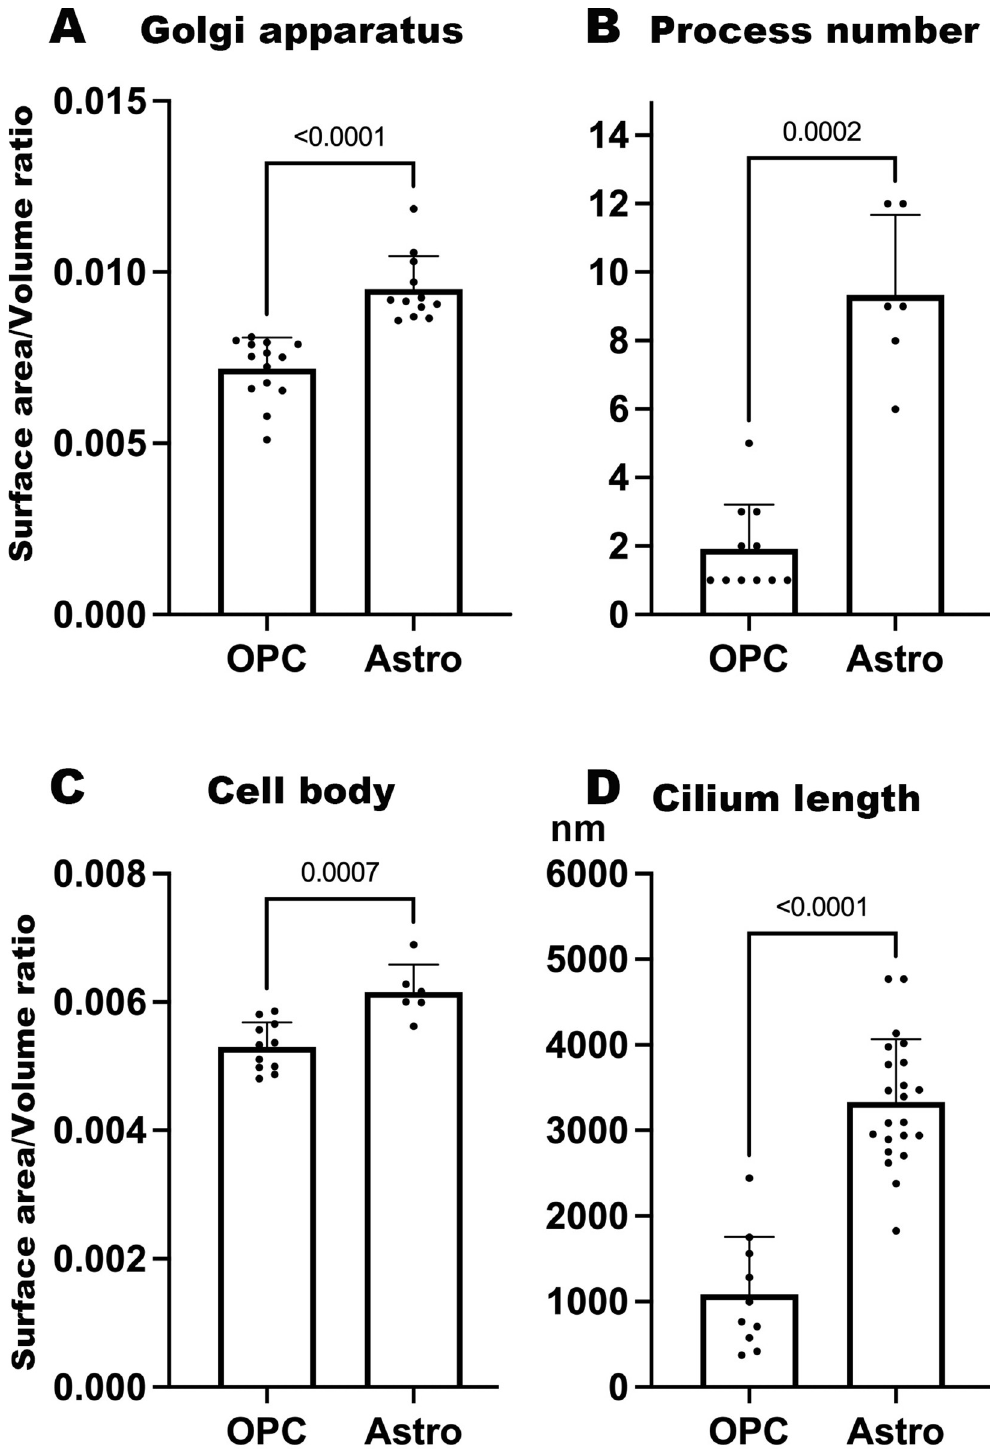
Fig 5. Quantitative analysis of differences between OPCs and astrocytes. (A) Ratio of the surface area and volume of Golgi apparatus. (B) Number of processes. (C) Ratio of the surface area to volume of a cell. (D) Length of the cilium in the pOPC and astrocyte. Values of A and C indicate unevenness in the surface of the structure. The p -values < 0.05 were considered to be significant.